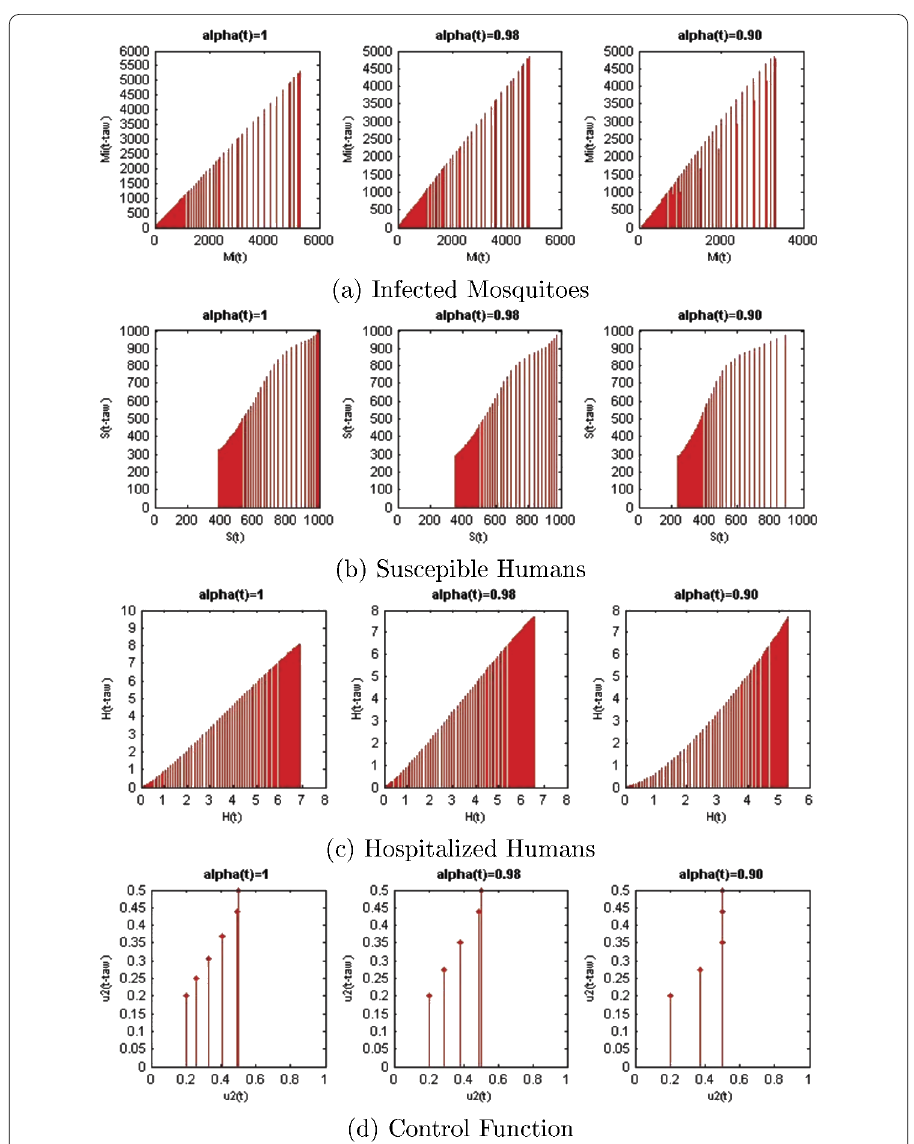
Figure 8 The relationship between the delayed variables and the non-delayed variables by using NSFDM. The delayed variables M i ( t – d ), S ( t – d ), H ( t – d ), u 2 ( t – d ) and the non-delayed variables M i ( t ), S ( t ), H ( t ), u 2 ( t ), respectively, with d = 5 and different α , (cid:7) t = 1